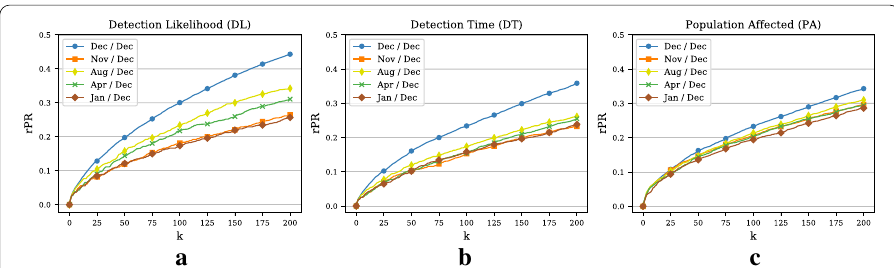
Fig. 9 Training and testing on different periods (Example 2). a Relative penalty reduction for the DL objective and different training periods. Testing is always done in December. b Relative penalty reduction for the DT objective and different training periods. c Relative penalty reduction for the PA objective and